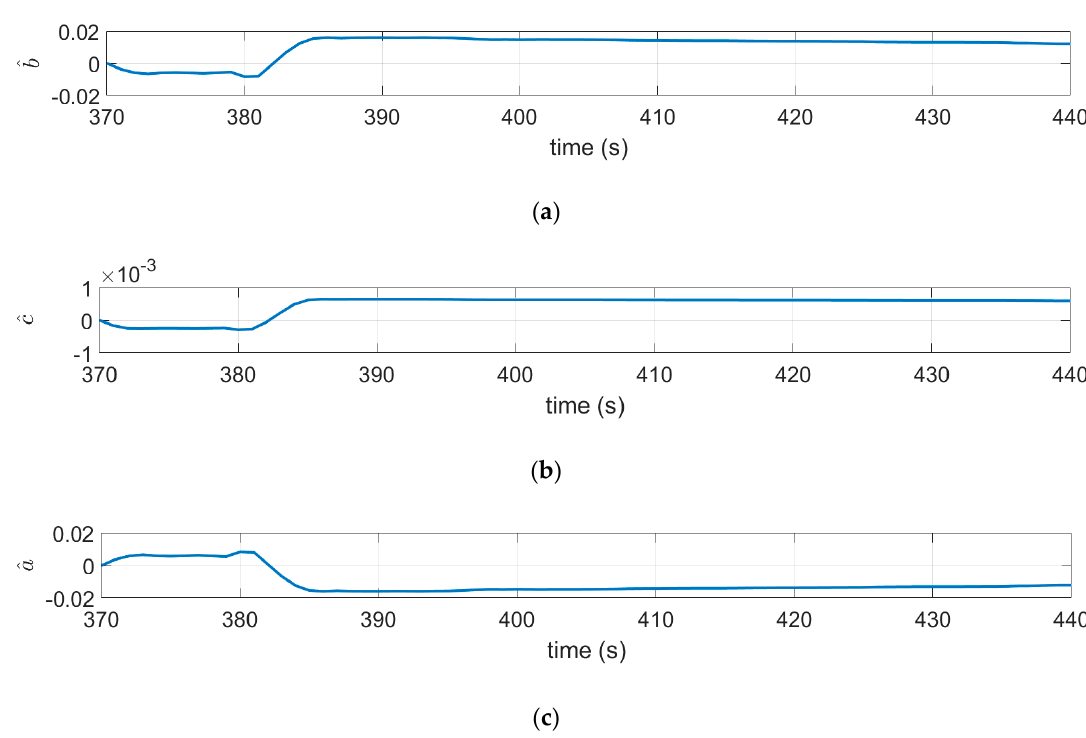
Figure 17. Experimental adaptation of three estimations: ( a ) estimation of parameter 𝑏 , ( b ) estimation of parameter 𝑐 , and ( c ) estimation of parameter 𝑎 .